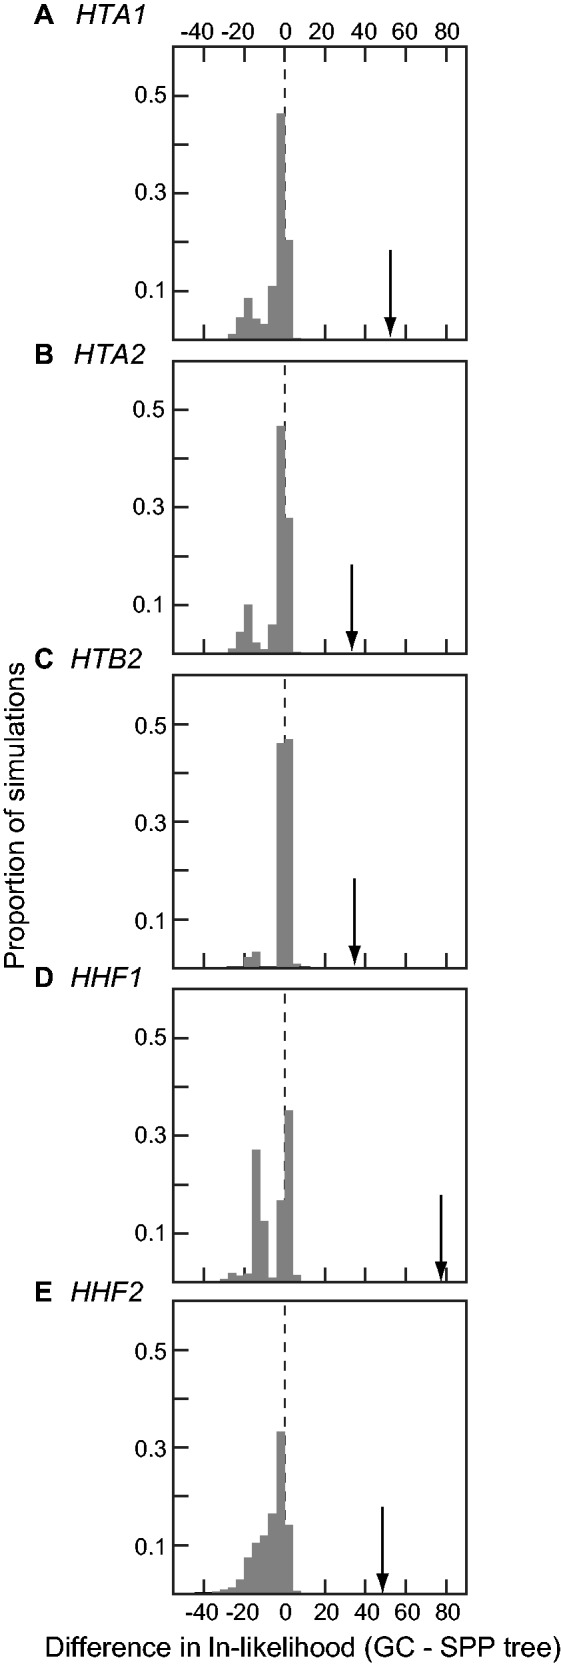
For all five examples of post-WGD GC, a tree joining the putatively gene-converted ohnologs explain the sequence data better than does the post-WGD species phylogeny. For each of the 5 loci, we simulated 1,000 sequence alignments under the presumed species tree (SPP) of figure 2 (omitting any branches where gene loss had occurred). We then analyzed those alignments under both the SPP tree and all possible GC trees. We calculated the difference in ln-likelihood between the best GC tree and the SPP tree. Thus, values greater than zero implies that the GC tree better explains the data than does the SPP tree. The proportion of simulations with a given value of the difference in ln-likelihood for the two trees is shown on the y-axis. For reference, we show the improvement in ln-likelihood seen under the GC tree for the real data with arrows.